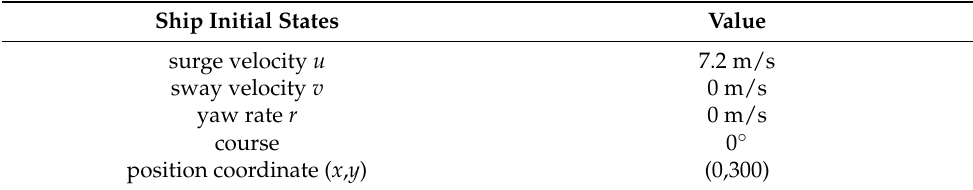
Table 2. Ship initial parameters.